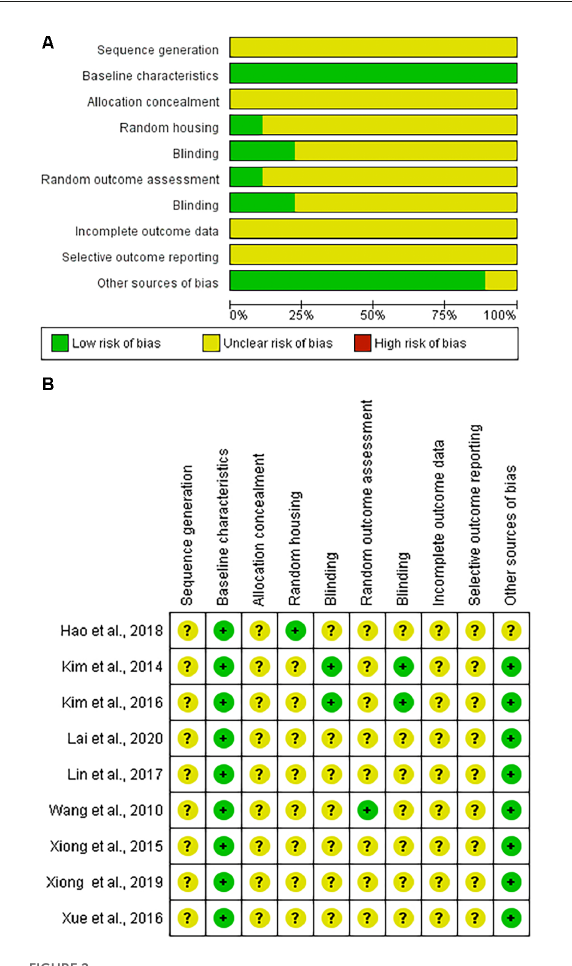
FIGURE2 SystematicReviewCenterforLaboratoryanimalExperimentation (SYRCLE) risk of bias assessment. (A) Graphic representation summarizing the assessment of the nine included articles. (B) Summary of individual article assessments by SYRCLE